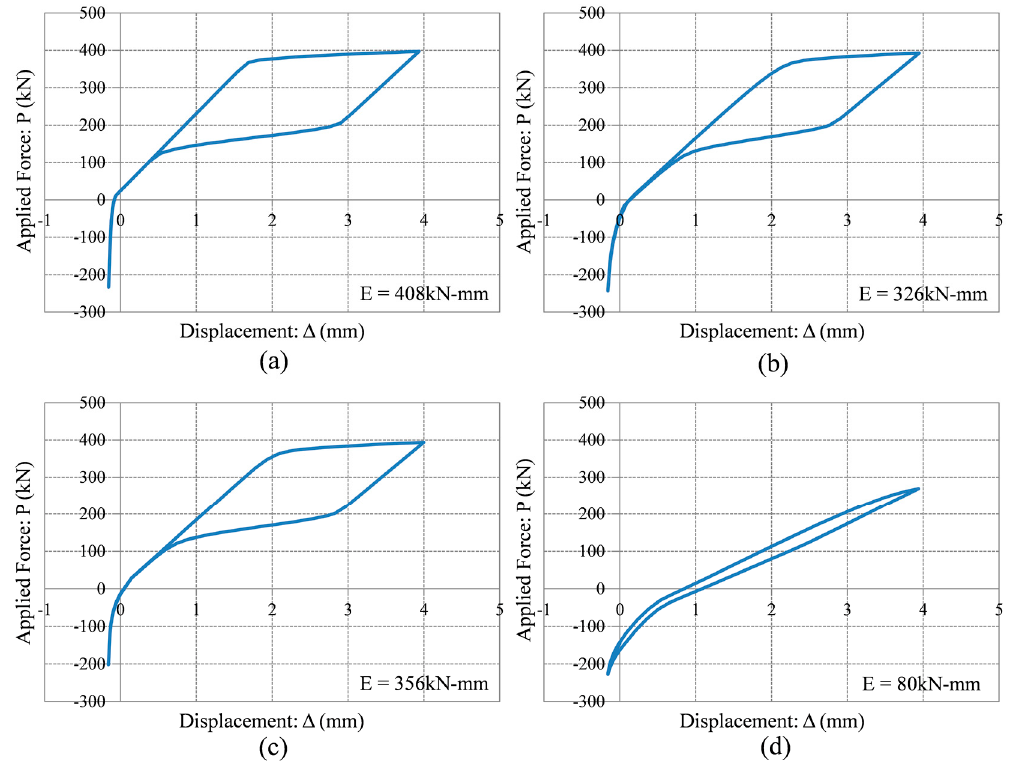
Figure 15. Energy dissipation capacity for four model cases during the last loading cycle: ( a ) Case-3; ( b ) Case-7; ( c ) Case-11; ( d ) Case-15.